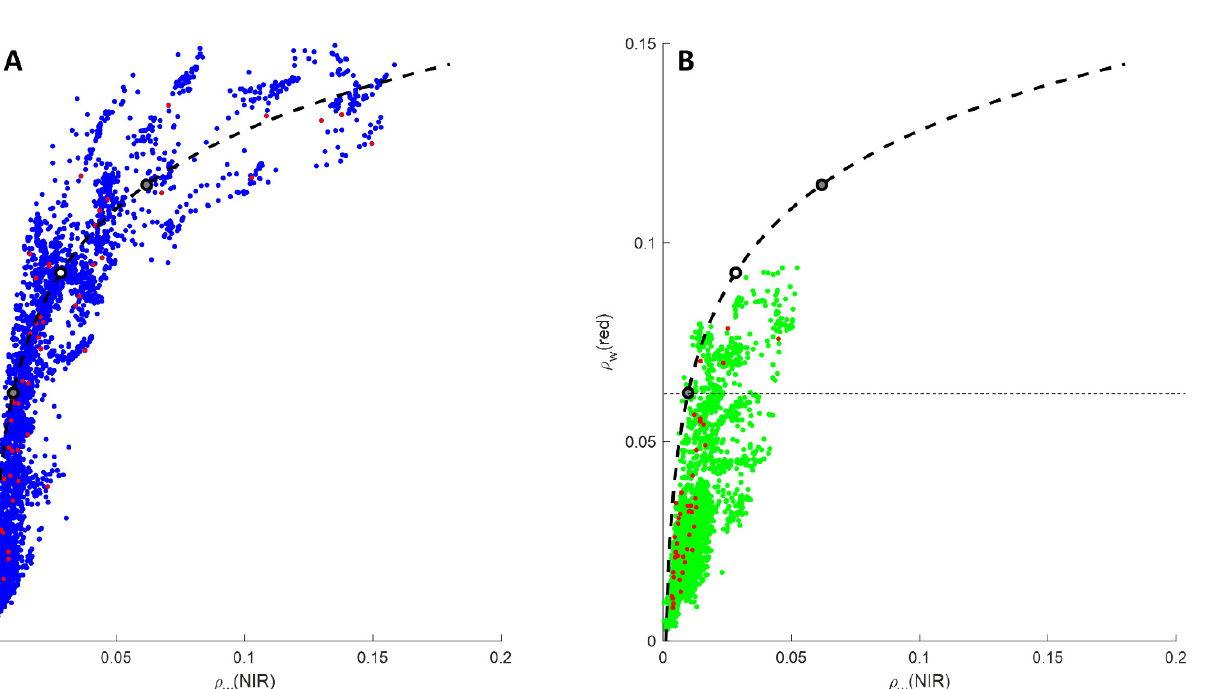
Figure A5. SPM concentration maps with the location of the transect points used in the study for OLI, MSI, and MODIS. The red points correspond to the SORA and MesuRho transect points. For MSI, the tiles end just after the Rhône River mouth; the transect is thus deviated towards the west in order to follow a smooth SPM concentration decrease as much as possible.